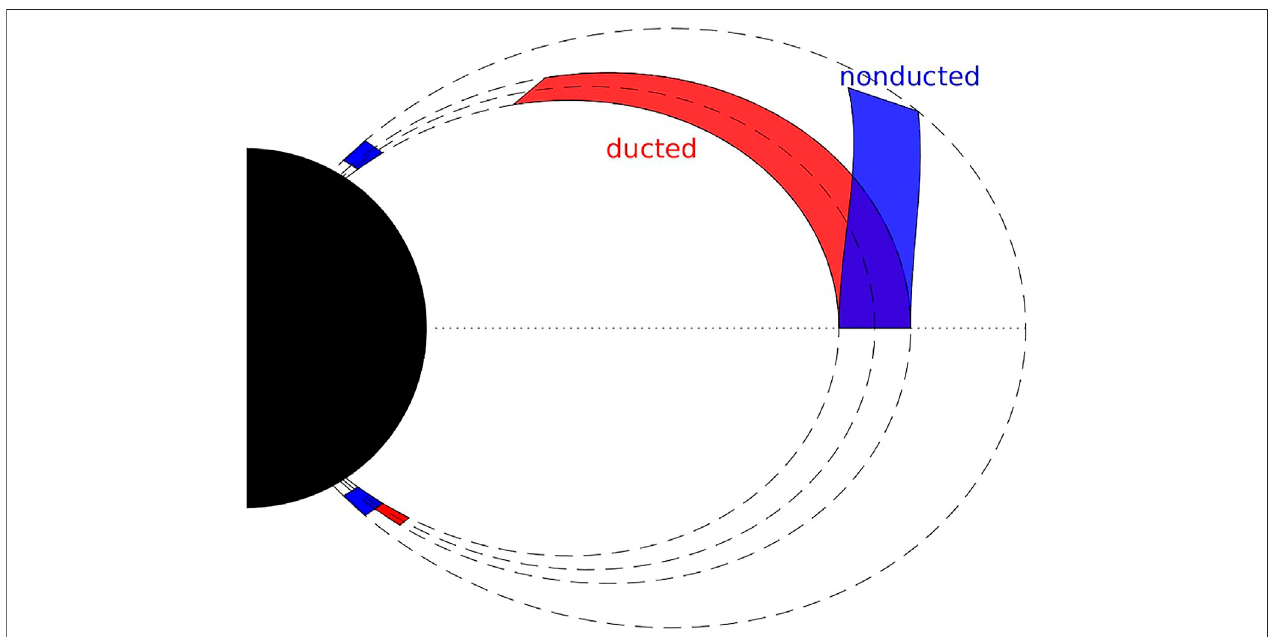
FIGURE 1 | Schematic illumination regions of electron precipitation due to interaction with ducted (shaded by red color) and nonducted (shaded by blue color) chorus waves that propagate northward. Dashed lines denotes the dipole magnetic fi eld lines. The schematic diagram is not scaled. Ducted chorus waves here only induce electron precipitation in the southern hemisphere while nonducted chorus waves induce electron precipitation in both